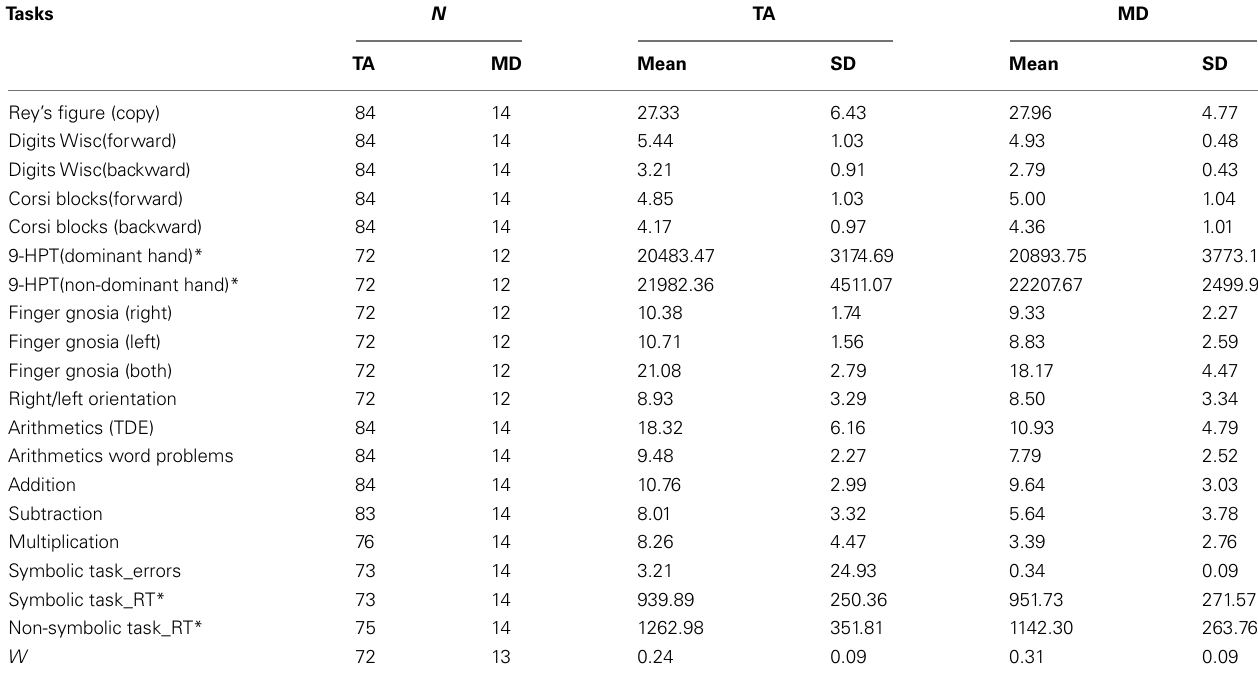
Table 2 | Descriptive data of the neuropsychological measures for each group.